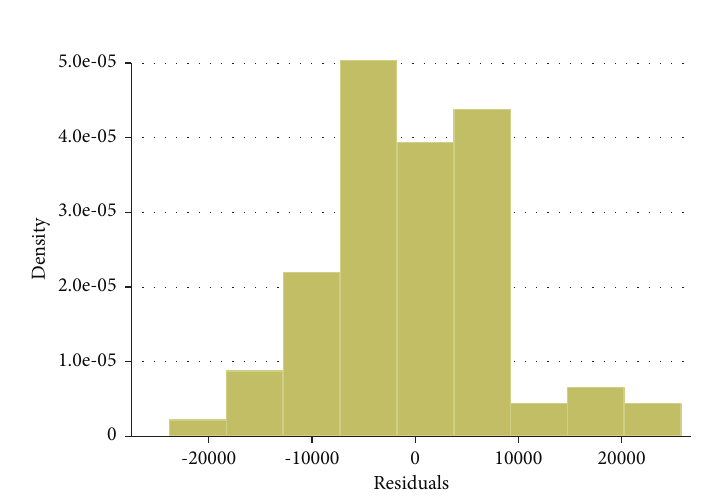
(Table 2). The estimated mean absolute percentage error (MAPE) was 10.4% (SD = 6.2).